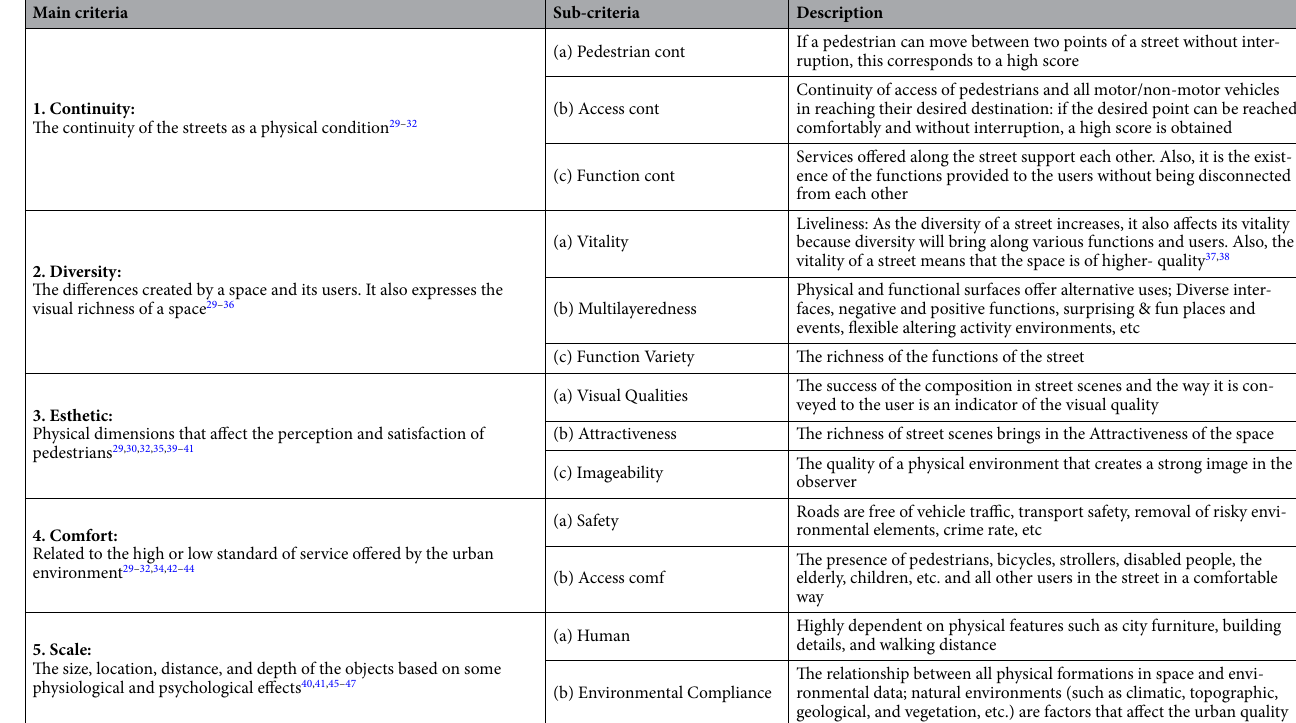
Table 2. Description of main and sub-criteria of street assessment [Umut Dogan 2021].